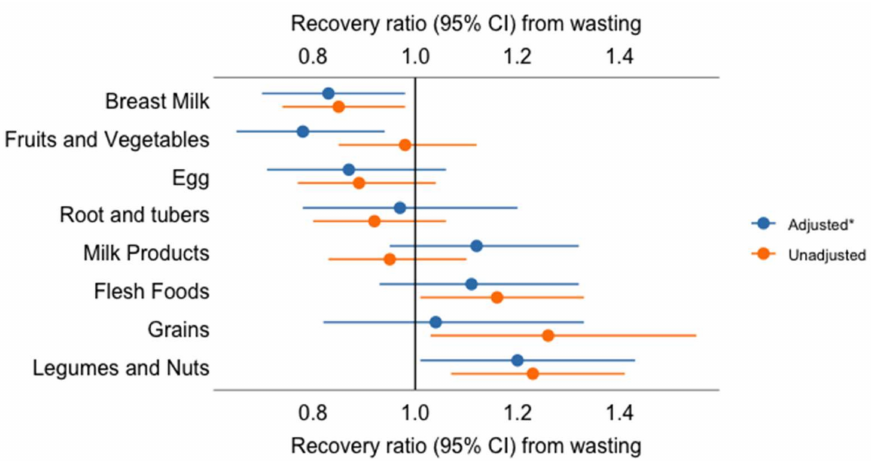
Figure 6. Association of specific food groups, food insecurity, and dietary diversity with recovery from wasting. * Adjusted for child age, child sex, child HIV status, child baseline nutritional status, discharge to nutritional program, parental educational status, maternal/caregiver depression, the season of enrollment, residence, study setting, duration of hospitalization, and wealth